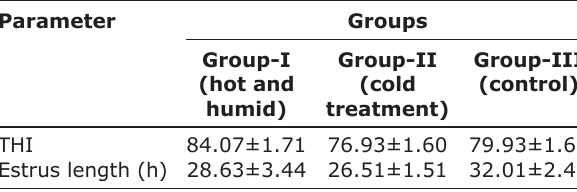
Table-1: Mean±SE of THI and estrus length of different housing system in different